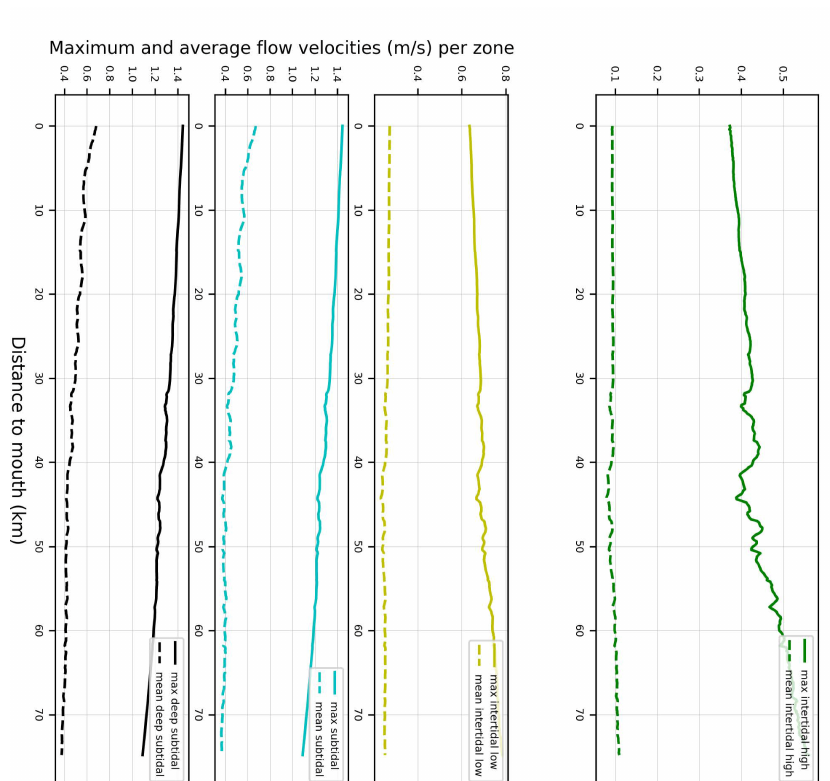
Figure A4. Tool output for the Western Scheldt. ( Top ) along-channel width of subtidal, intertidal low and intertial high zones; ( center ) average depth of subtidal, intertidal low and intertial high zones; ( bottom ) average and maximum flow velocity of subtidal, intertidal low and intertial high zones.